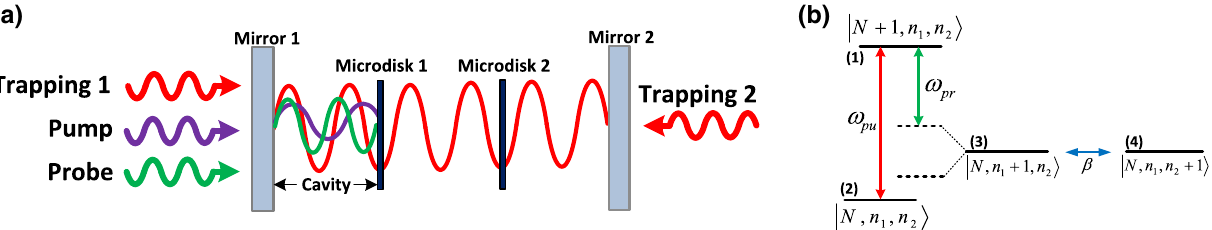
Fig. 1 a Schematic diagram of the cavity optomechanical system with two levitated microdisks. The cavity mode is driven by a strong pump laser and probed by a weak probe laser. The levitated microdisks are